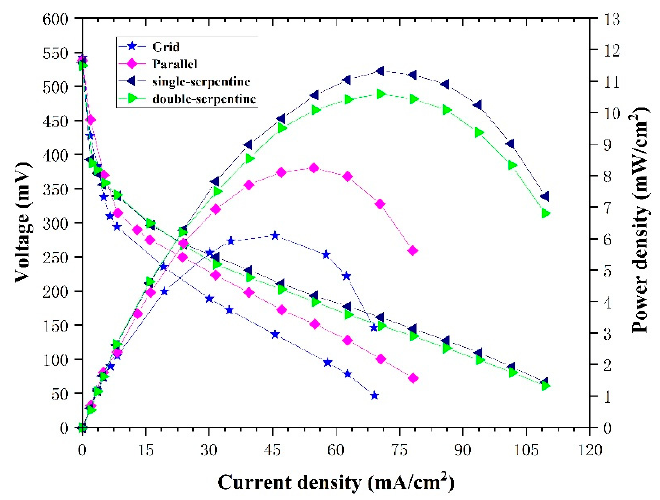
Figure 11. Polarization curves and power density curves of different flow fields under the same experimental conditions.